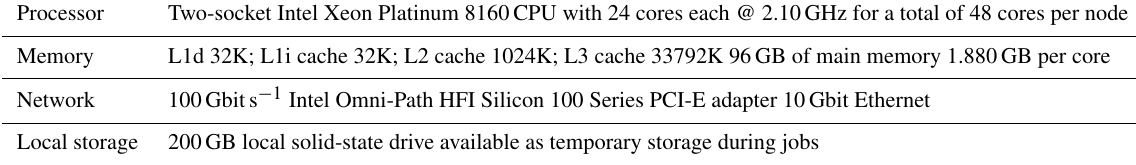
Table 2. Marenostrum 4 node specifications.